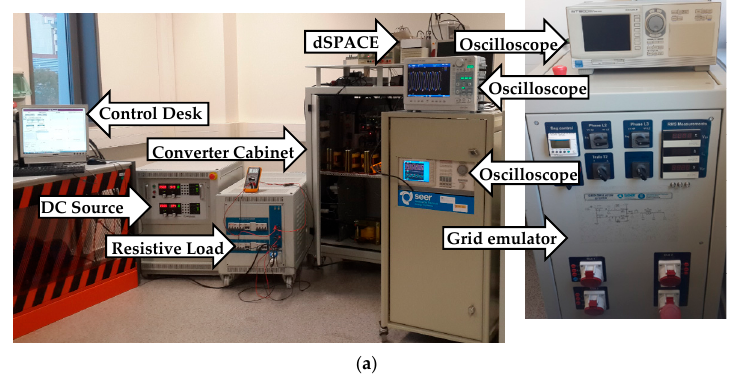
Figure 14. Different scenarios of active and reactive power injection: ( a ) When grid inductance, L g = 10 μ H; ( b ) When grid inductance, L g = 10 mH; ( c ) When L g = 5